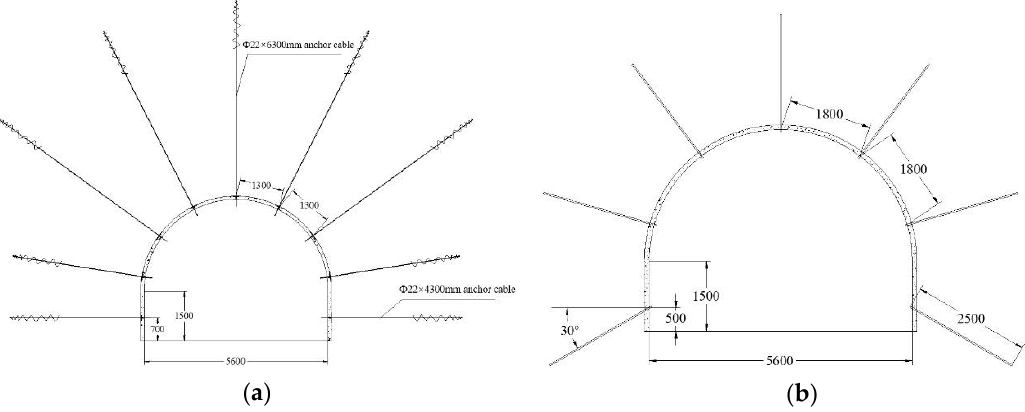
Figure 20. Schematic diagram of support scheme (mm). ( a ) Arrangement of side and roof anchor cables ( b ) Grouting reinforcement parameter.